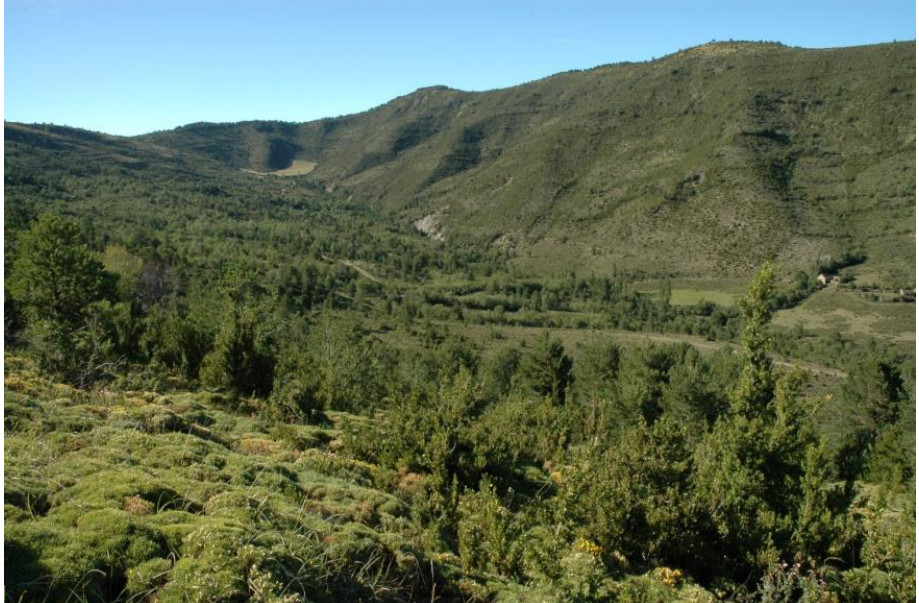
Figure 1. Plant colonization in abandoned fields in a wet environment (Arnás catchment, Central Spanish Pyrenees). Forest stands occupy the gentle slopes in the forefront whereas the steep slopes in the background are colonized by shrubs. Photo by Jérôme Latron.